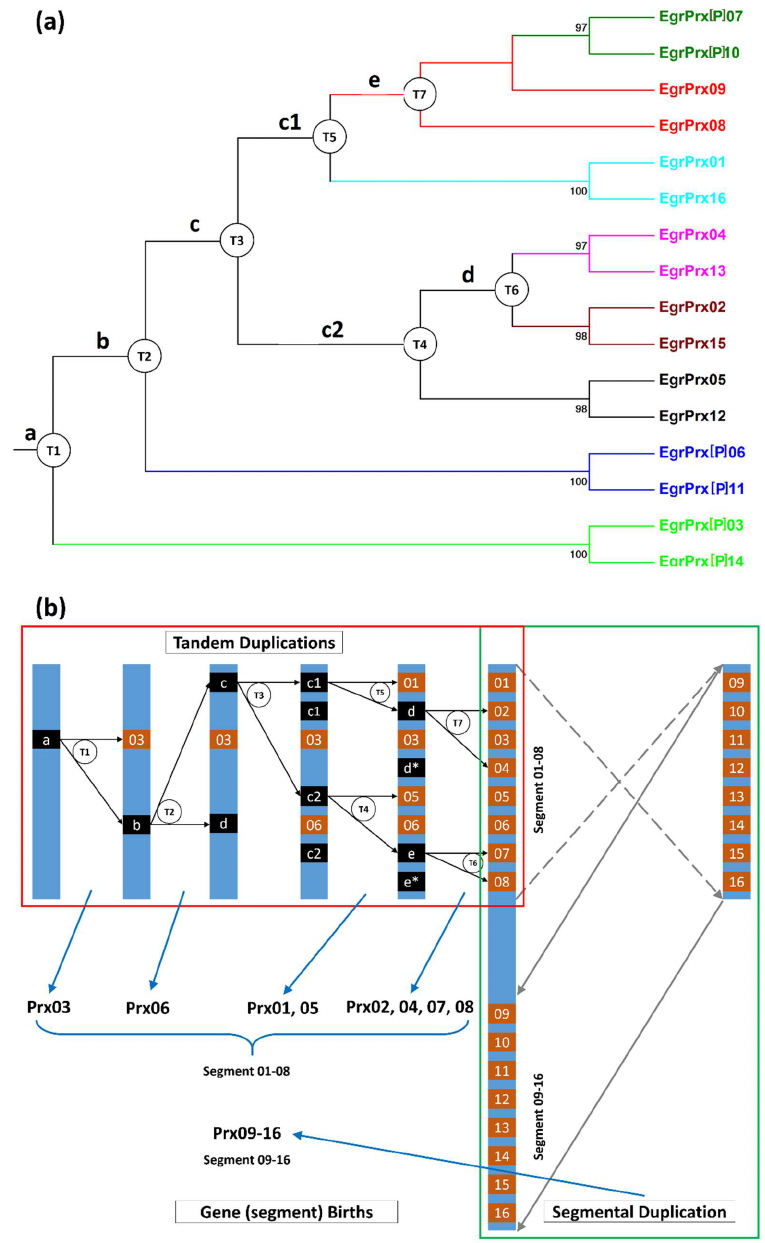
Figure 5. Phylogenetic relationships and hypothetical evolutionary histories of two duplicated segments. (a) Phylogenetic tree of the 16 genes. Genes were given different colors according to the colors in Figure 5. The percentage of trees in which the associated taxa clustered together is shown next to the branches. The alignment was performed by MAFFT and the tree was visualized by Mega 6. Cycled letters T with following numbers represent the TD events; (b) Schematic diagram of the evolutionary histories of the 16 genes. The putative TD process was visualized in the red rectangle while the SD process in green rectangle. Genes shown with black rectangles (named a, b, c, d and e) represent the ancestors of some CIII Prx genes appeared in the evolutionary process. Asterisk (*) represents the alternative localization of the ancestral gene named with the same letter. T1–T7 represent the tandem duplication events. 1–16 represent Prx01–16. The dotted arrow (grey) in B shows the reversing process of gene segment while the grey arrow represents the genomic insertion event. Cycled letters T with following numbers represent the TD events. The order of gene apparition (genes Prx01–16) was displayed on the lower left corner. Gene sizes are not up to